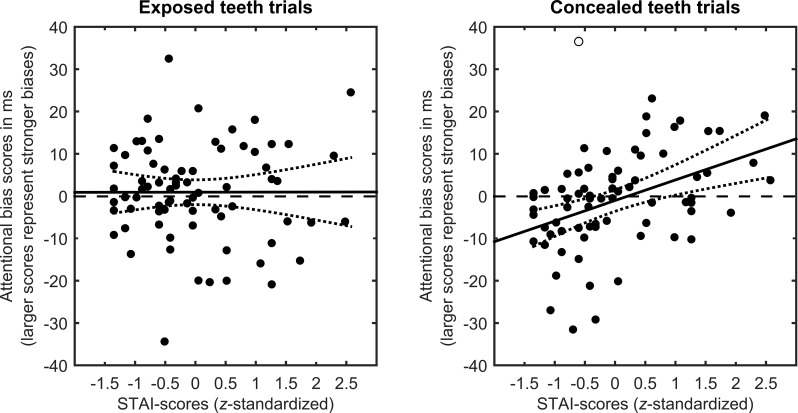
Scatterplots illustrating the relationship between participants’ STAI-scores and their individual attentional bias scores (in ms) on exposed teeth trials (left panel) and concealed teeth trials (right panel). The empty circle marks an excluded bivariate outlier (see text). The solid line depicts the slope of the regression, the dotted lines the 95%-confidence interval of the slope. For the sake of clarity, the attentional bias scores depicted here are based on non-transformed reaction times (RT-invalid–RT-valid).